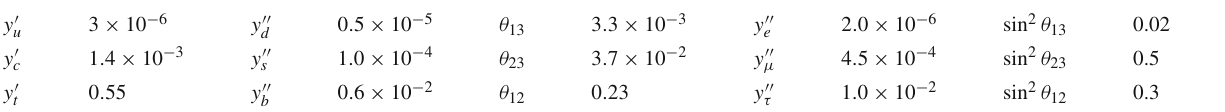
Table 1 Quark and lepton data at the GUT scale in the MSSM [6]. Here, y (cid:4) depend on the supersymmetric threshold corrections, and indirectly on tan β via the renormalization group